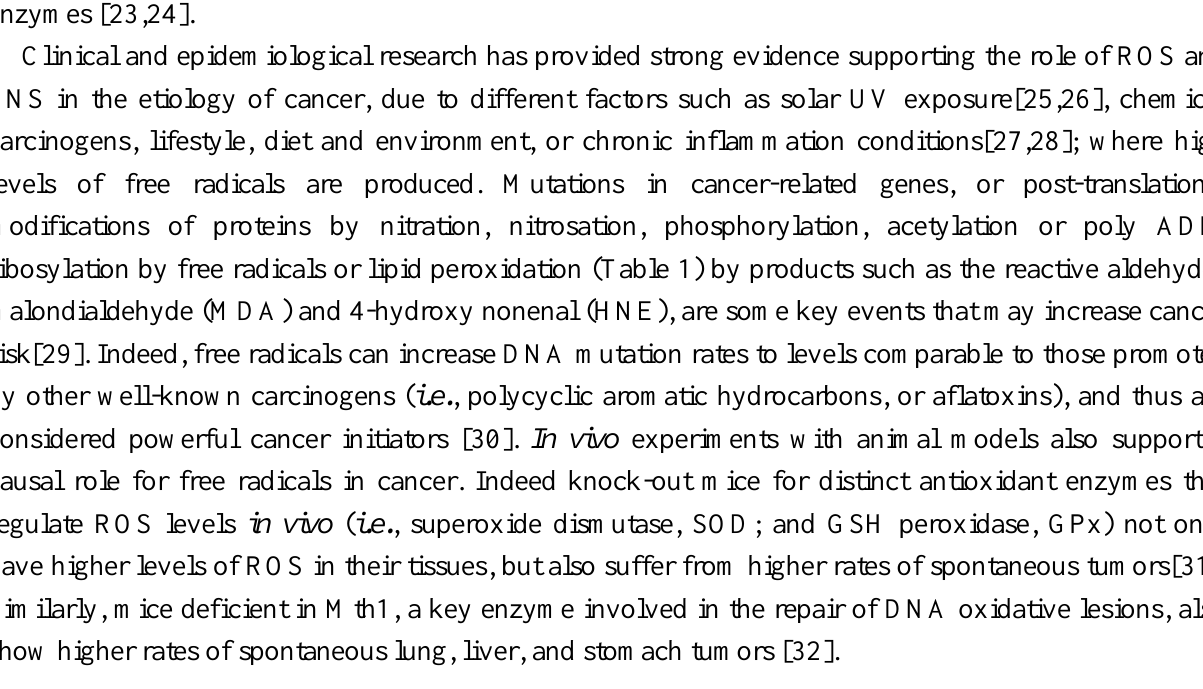
Table 1. Molecular damages induced by ROS and RNS.